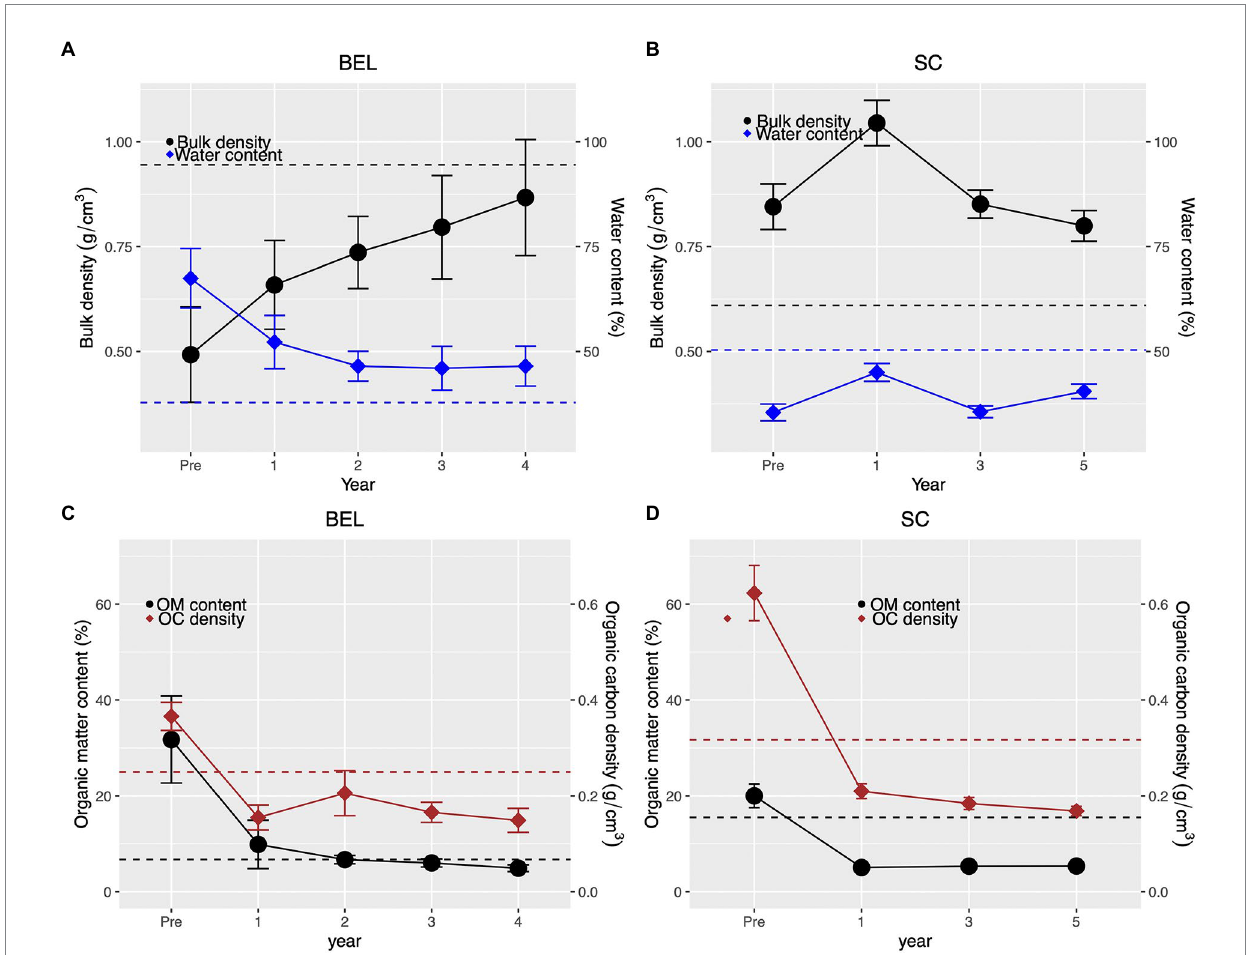
FIGURE 7 (A,B) Sediment core bulk density and water content at BEL and SC restoration sites. Dotted horizontal lines represent the average value for cores taken at the respective reference sites. (C,D) Sediment core organic matter content and organic carbon density changes at BEL and SC restoration sites. Dotted horizontal lines represent the average value for cores taken at the respective reference sites; error bars are standard errors.